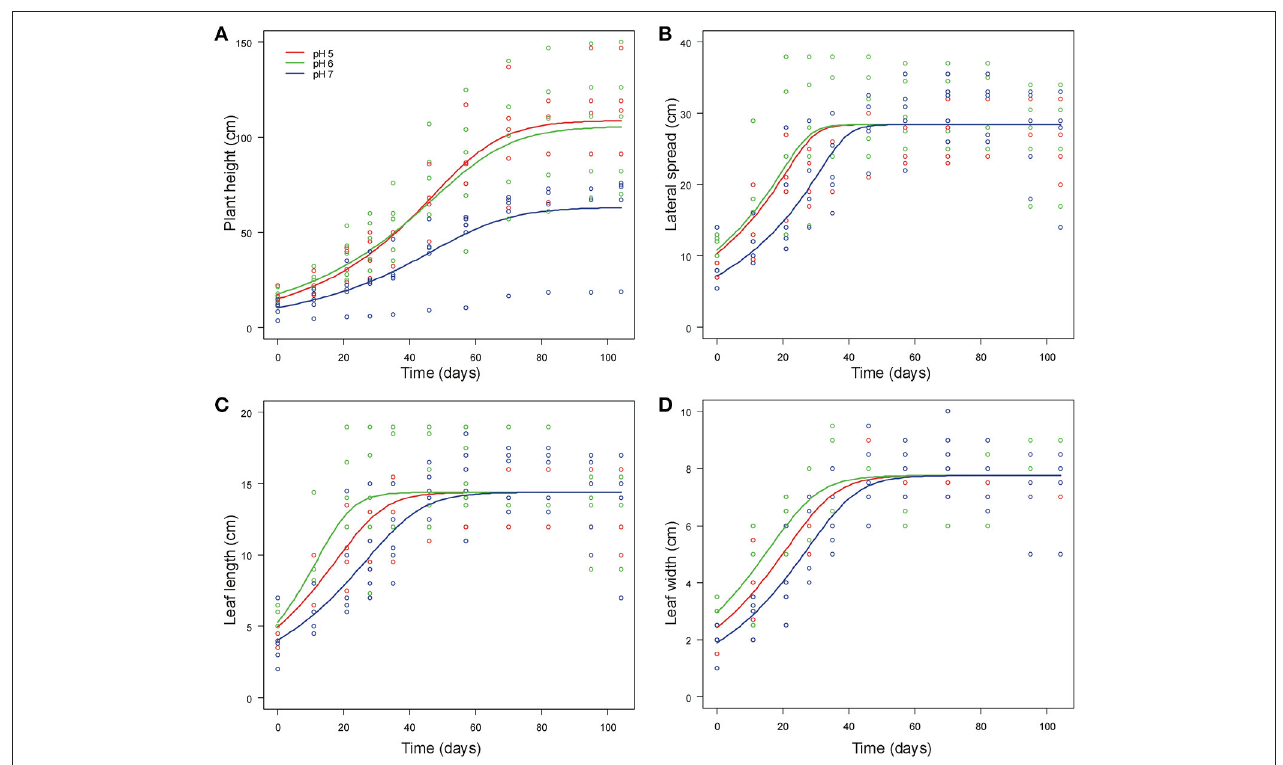
FIGURE 2 | Generalized logistic growth curves of vegetative traits [plant height (A) , lateral spread (B) , leaf length (C) and leaf width (D) ] of A. artemisiifolia according to different pH values (pH5, pH6 and pH7, displayed in different colors) at 25 ◦ C.